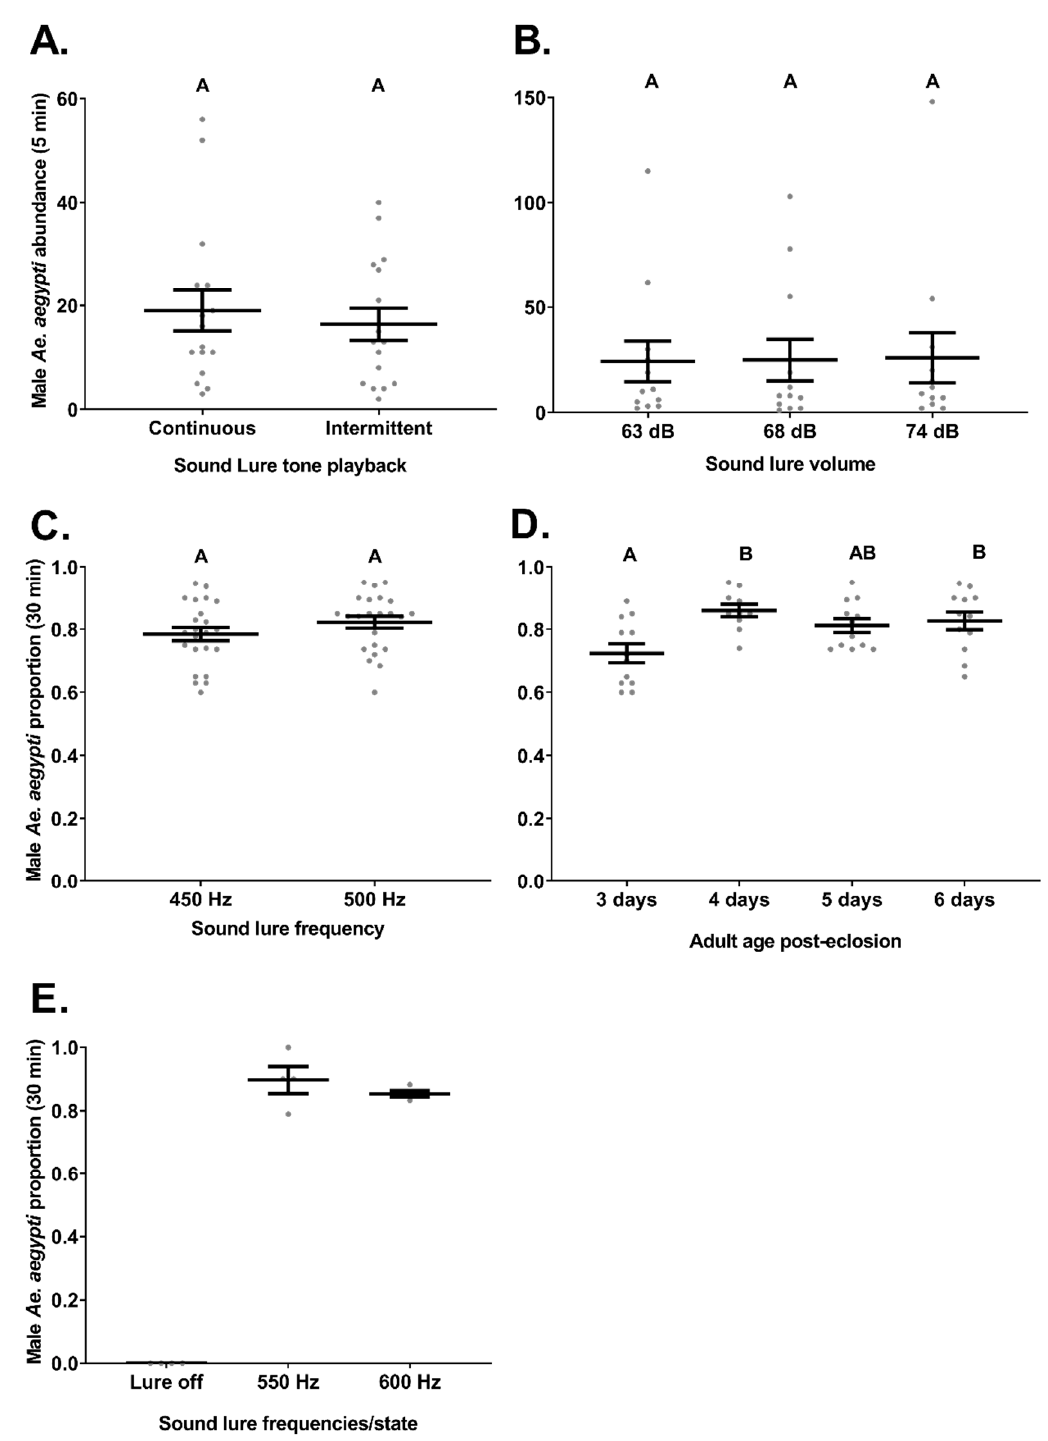
Figure 4. The influence of different sound lure configurations on male Ae. aegypti (mean ± S.E.) catch rates in the MAST. Trials investigated catches of male Ae. aegypti per ( A ) five-minute semi-field trials comparing male catches in MASTs ( n = 12) with sound lures that either played continuously or intermittently (30 s on and off), ( B ) five-minute semi-field trials comparing male catches in MASTs ( n = 12) with sound lures set to different volumes, ( C ) thirty-minute tent trials comparing male catches in MASTs ( n = 23) with sound lures set to different frequencies, ( D ) thirty-minute tent trials comparing catch rates of males of various post-eclosion ages in MASTs ( n = 10–12) set to 500 Hz and 60 dB, and ( E ) thirty-minute tent trials comparing male catches in MASTs ( n = 4) with sound lures set to different frequencies or turned off. Different letters indicate significantly different groups (Tukey HSD, p ≤ 0.05).